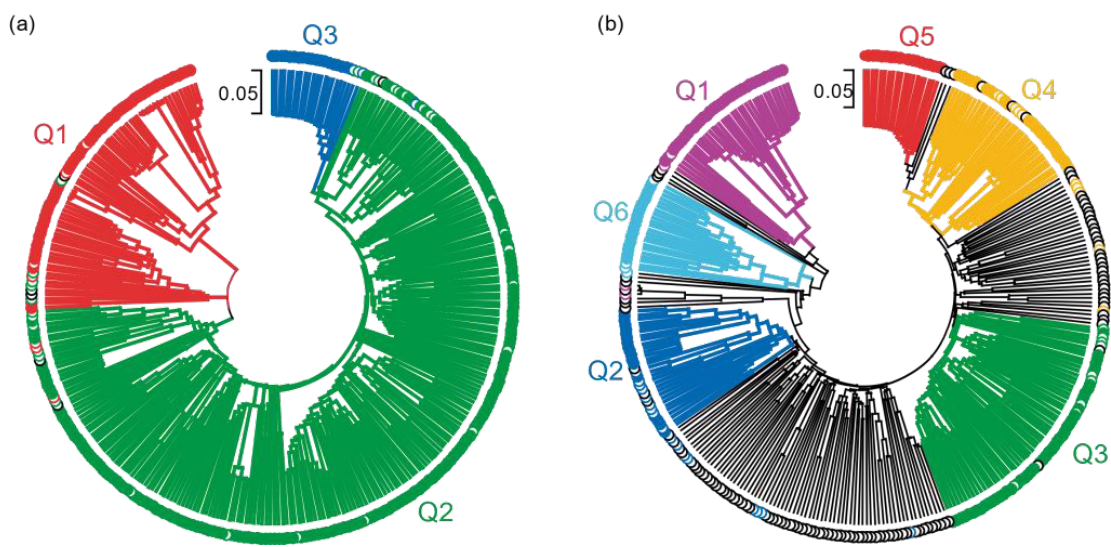
Figure 6. Phylogenetic relationship of the IAS pea core collection. The phylogenetic relationships were inferred using the Neighbor-Joining method with 1000 bootstraps. The tree was drawn to scale, with branch lengths corresponding to the number of differences per site. The evolutionary distances were computed using the p-distance method. The rate variation among sites was modelled with a gamma distribution (shape parameter = 0.98). All positions with more than 5% missing data were eliminated (partial deletion option). There was a total of 11,635 markers in the final dataset. The branch of each accession was coloured depending on its STRUCTURE subpopulation (Q) for K = 3 ( a ) or K = 6 ( b ).